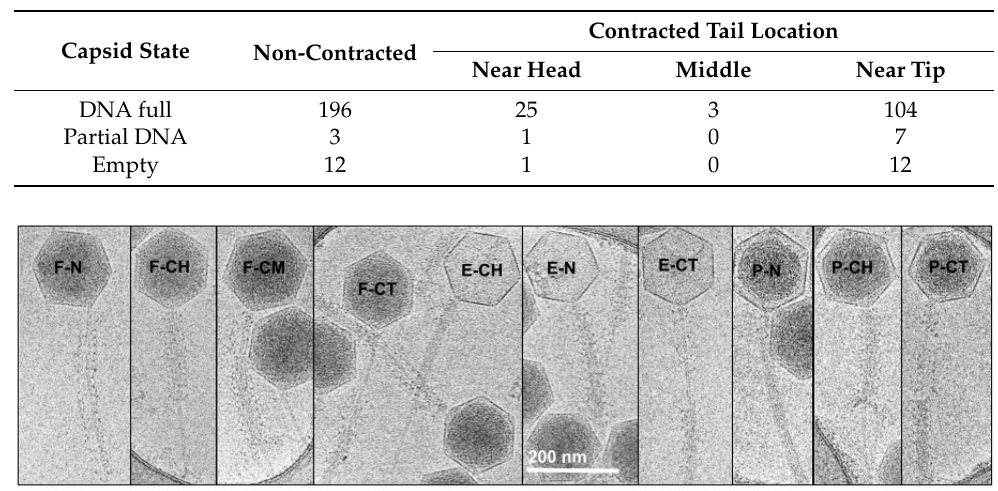
Table 1. Tail contraction and head states from cryo-EM micrographs.